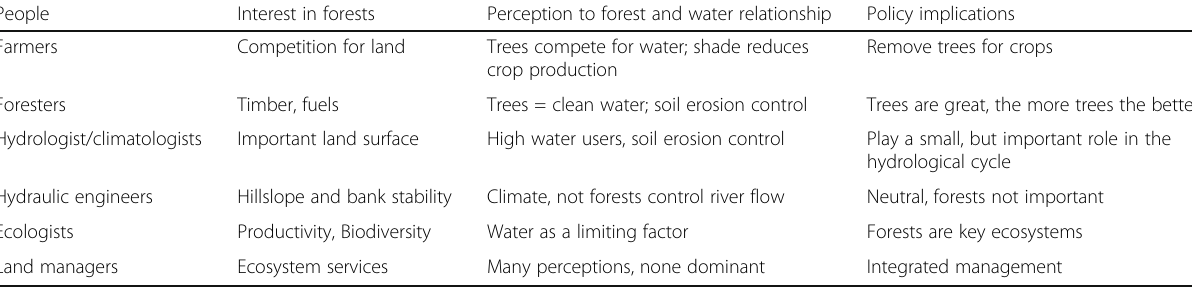
Table 1 A comparison of common differences in perceptions among different ecosystem users about forests and water and potential policy implications People Interest in forests